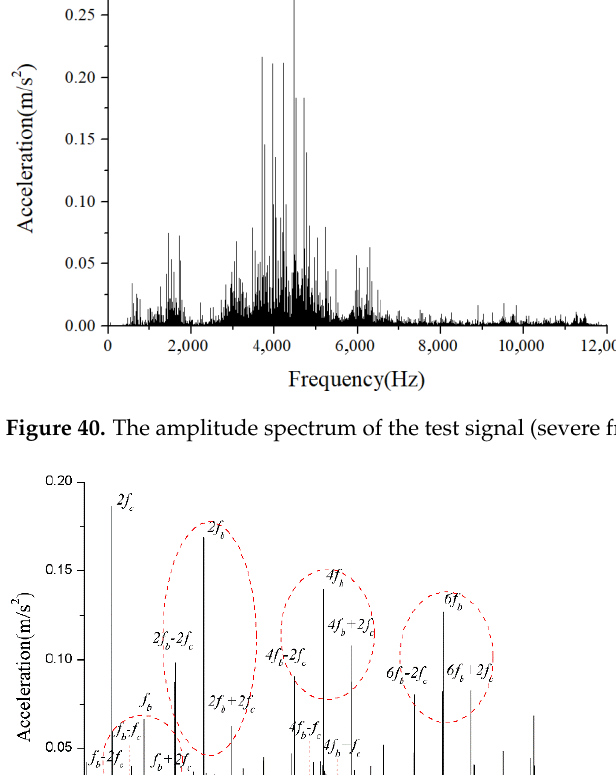
Figure 41. Acceleration envelope spectrum (severe friction).